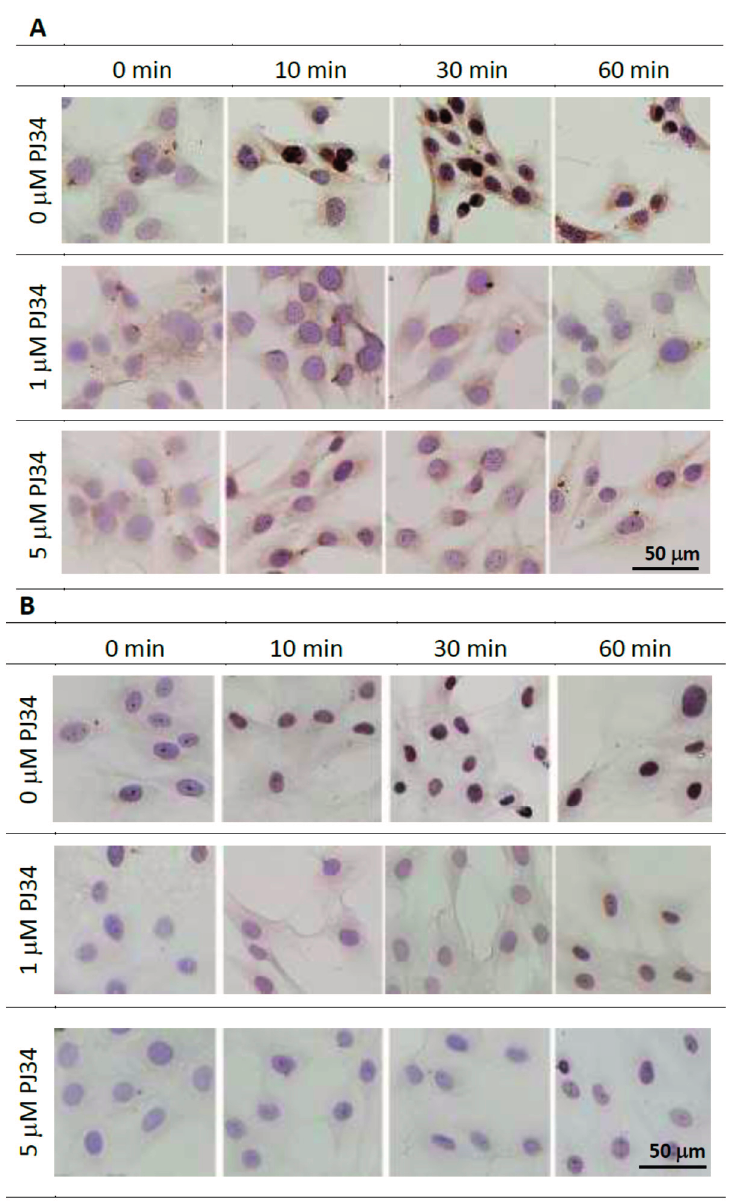
Figure 3. Inhibition of PARP activity in the presence of 1 and 5 µM PJ34 was confirmed by immunocytochemical analysis with anti-PAR antibody in BMMSCs ( A ) and KUSA-A1 cells ( B ), respectively. Scale bars = 50